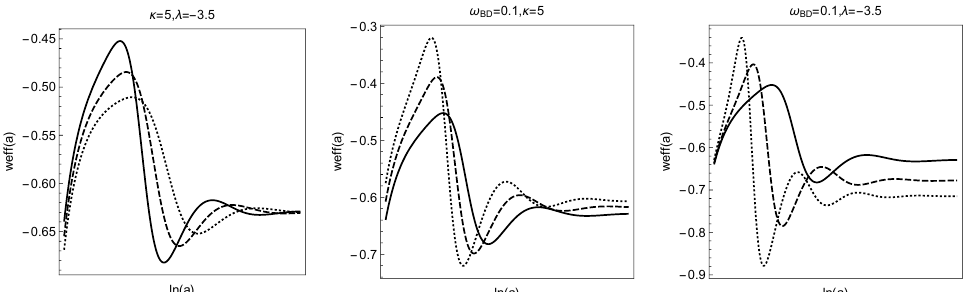
Figure 2. Qualitative evolution of the w ef f with a future atractor point A + . Left Figure is for 3 = 0.1 (solid line), ω = 0.2 (dashed line) and ω = 0.3 (dotted line). ( κ = 5, λ = − 3.5 ) , and ω BD BD BD Center Figure is for ( ω BD , κ ) = ( 0.1,5 ) , λ = − 3.5 (solid line), λ = − 3.6 (dashed line) and λ = − 3.7 (dotted line). Right line is for ( ω BD , λ ) = ( 0.1, − 3.5 ) , κ = − 3.5 (solid line), κ = − 3.6 (dashed line) and κ = − 3.7 (dotted line).